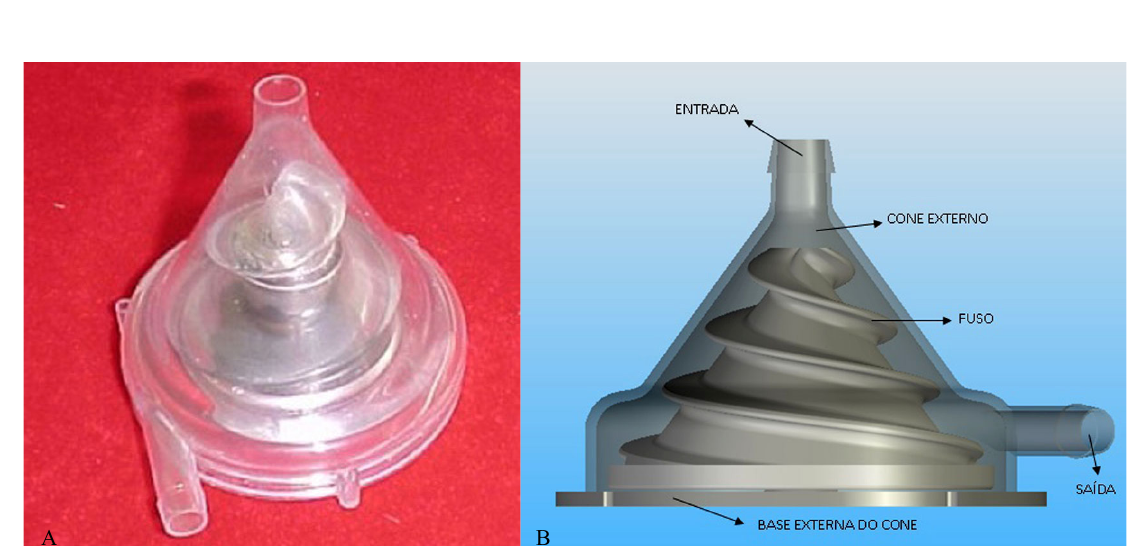
Fig. 1A - Original prototype, developed in 1992 and 1B - The new model, developed in 2007, with two thread entrances and with the modified device's external base [5,6] .